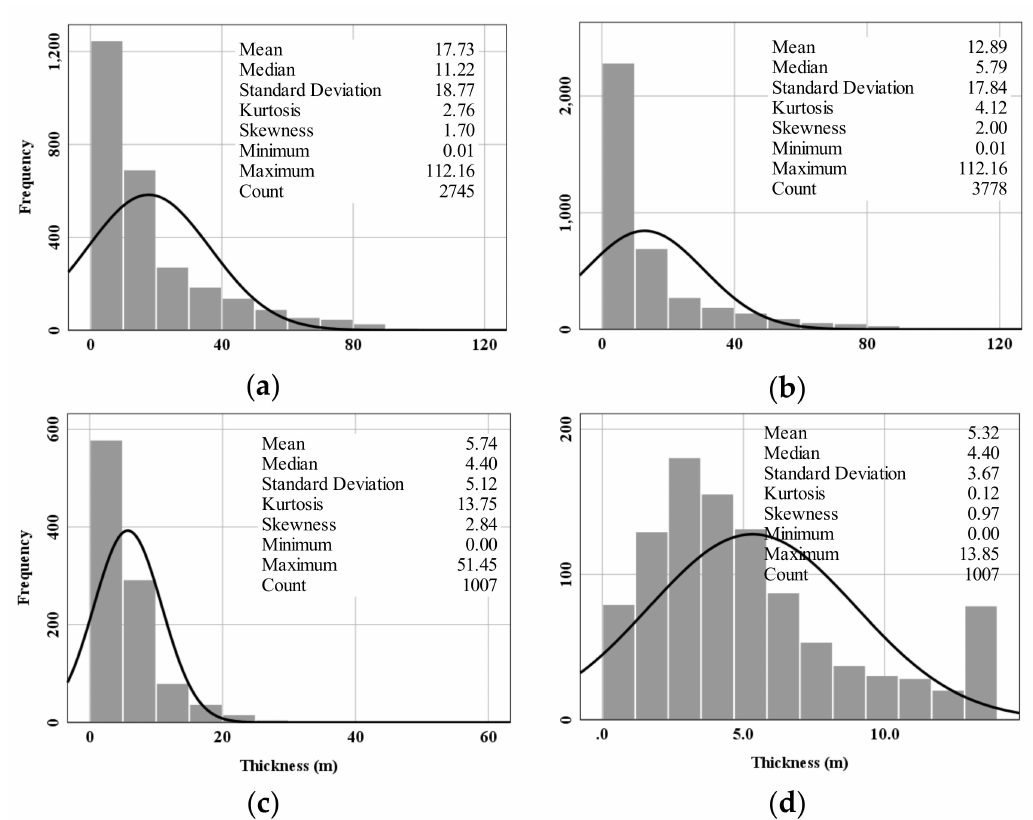
Figure 7. Thickness distributions of soil deposits as observed in borehole logs: ( a ) total soil thickness, depth to rock; ( b ) total soil thickness, including rock outcrops; ( c ) till sediments; ( d ) till sediments following replacement of outliers. The black line represents the normal distribution curve.